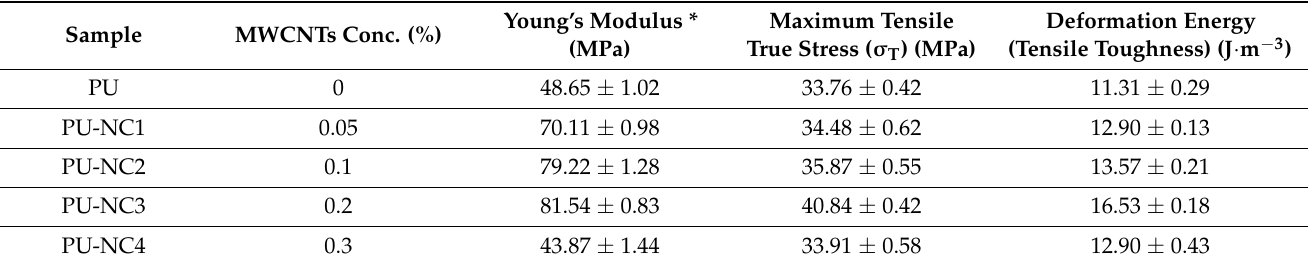
Table 5. Mechanical properties of polyurea-polyurethane- MWCNTs nanocomposites.